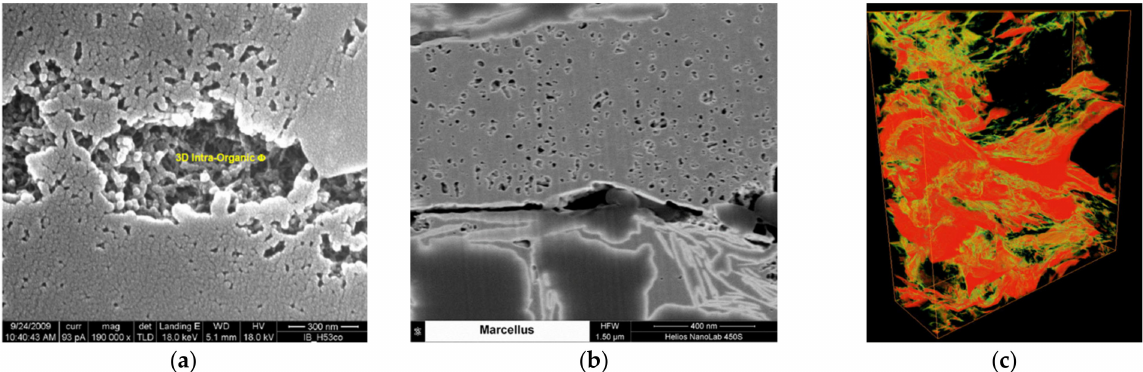
Figure 5. ( a ) Well-developed kerogen-hosted porosity, wet gas region southwestern Pennsylvania (SEM image courtesy William Zagorski, Range Resources). ( b ) Pyrobitumen-hosted organic porosity, dry gas region, northeastern Pennsylvania (from Laughrey et al. [12]). SEM images in ( a ) and ( b ) are the same scale. ( c ) 3D focused ion beam SEM model of interconnected pyrobitumen-hosted organic porosity in the same sample shown in ( b ). Red—pyrobitumen. Yellow—interconnected porosity. Horizontal field width = 8 µ